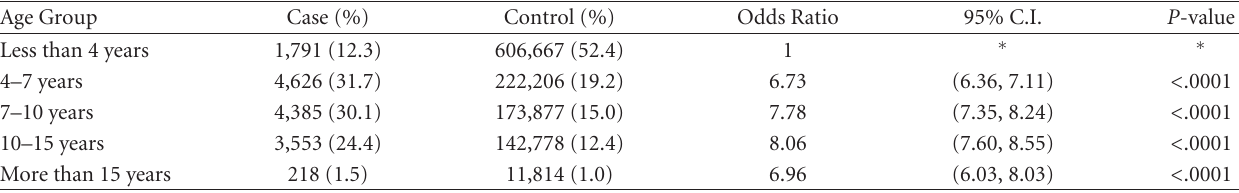
Table 3: Logistic regression model defining the risk of a diagnosis of lymphoma in dogs in the VMDB (1964–2002) as a function of age.